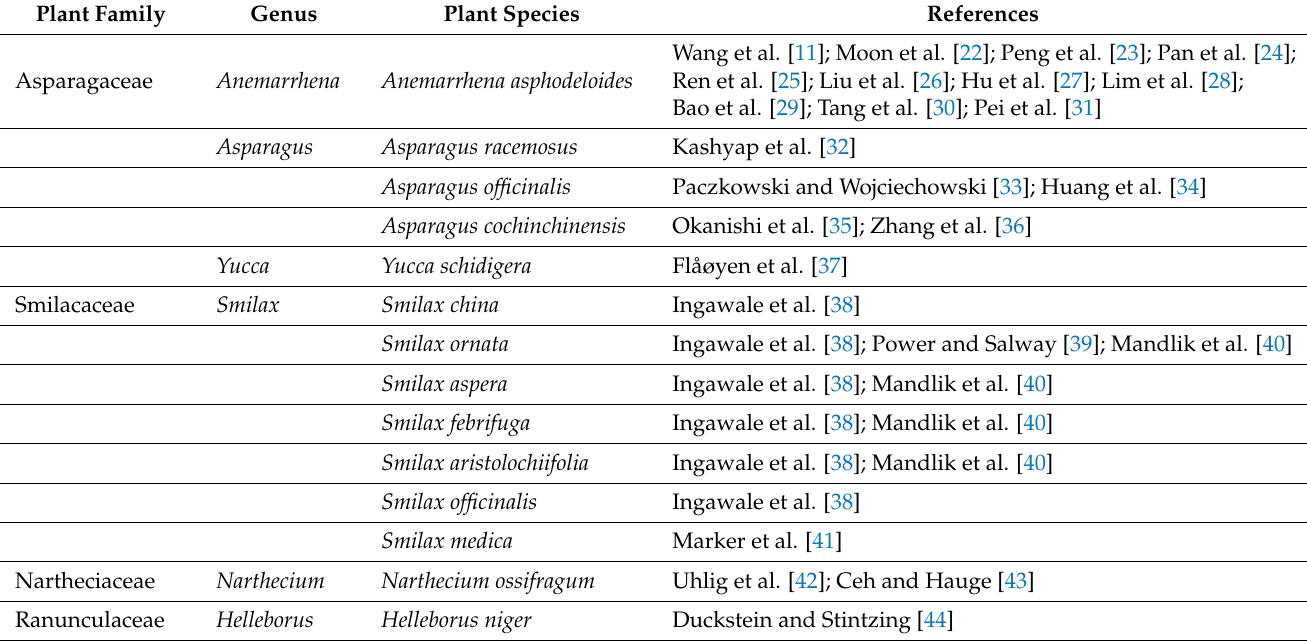
Table 1. List of medicinal plants containing